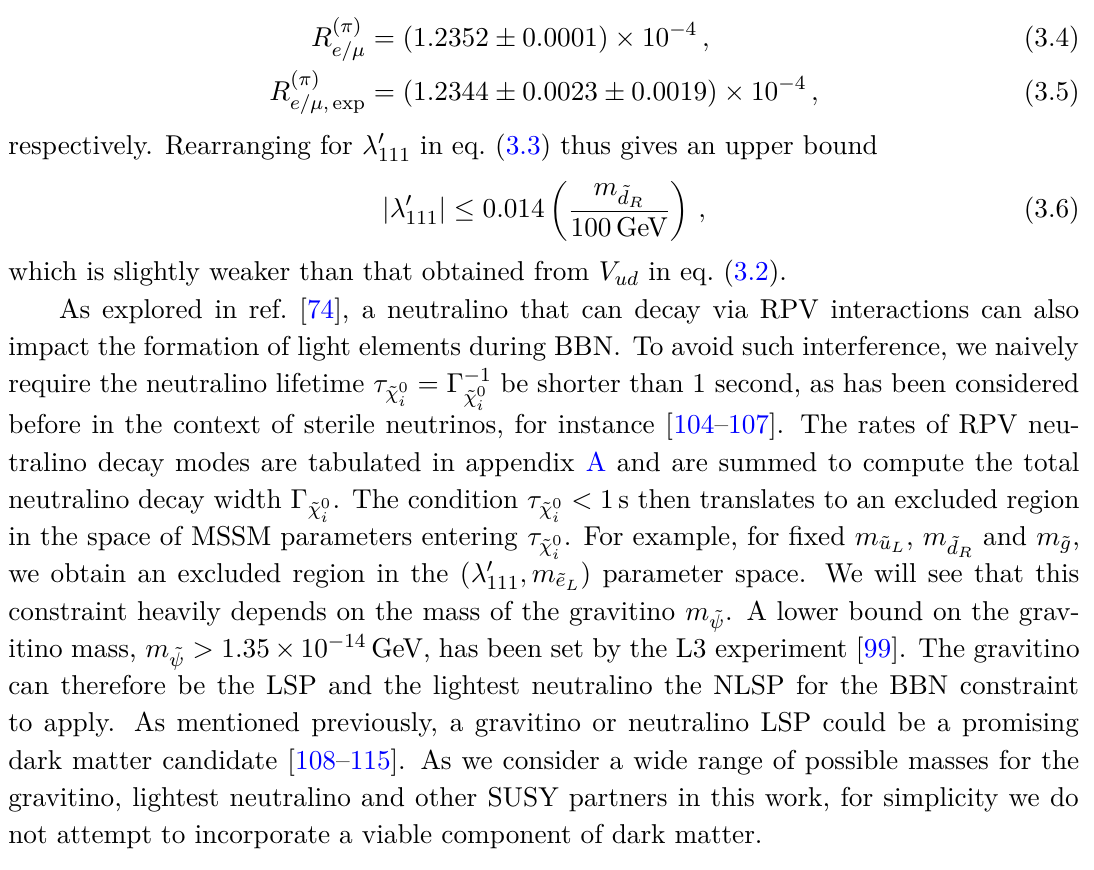
figure 1. The neutralino-mediated diagram can proceed by the exchange of a selectron, up or down squark at the effective interaction vertices, shown in figure 2, while the gluino- mediated diagram can only take place for the exchange of color-charged up or down